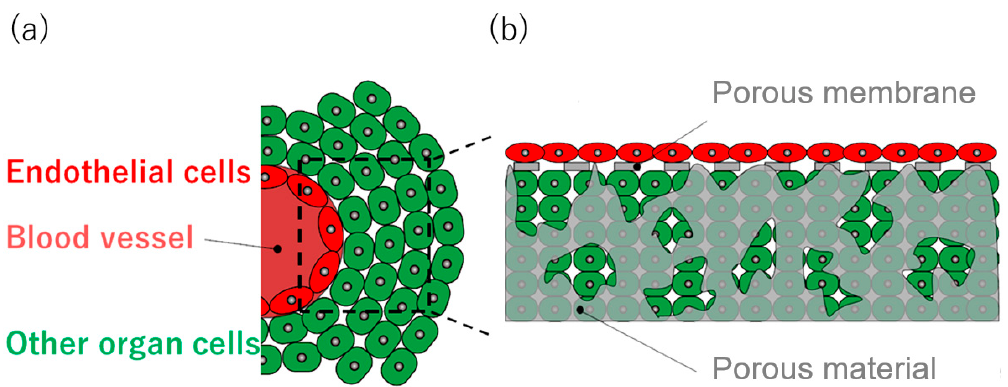
Figure 1. Schematic images of natural cellular tissue and cellular tissue on the sca ff old. The cellular tissue inside the body consists of tissues with 2D / 3D shapes. The cell layer which has a 2D shape creates a boundary between the inside / outside of the body, or between tissues. The 3D cellular tissue is arranged on the 2D tissue ( a ). The artificial sca ff old MIS with a 2D porous membrane and the 3D porous material has the potential to create a similar structure to that of in vivo tissue, such as a blood vessel and organ cells, by seeding cells onto it ( b